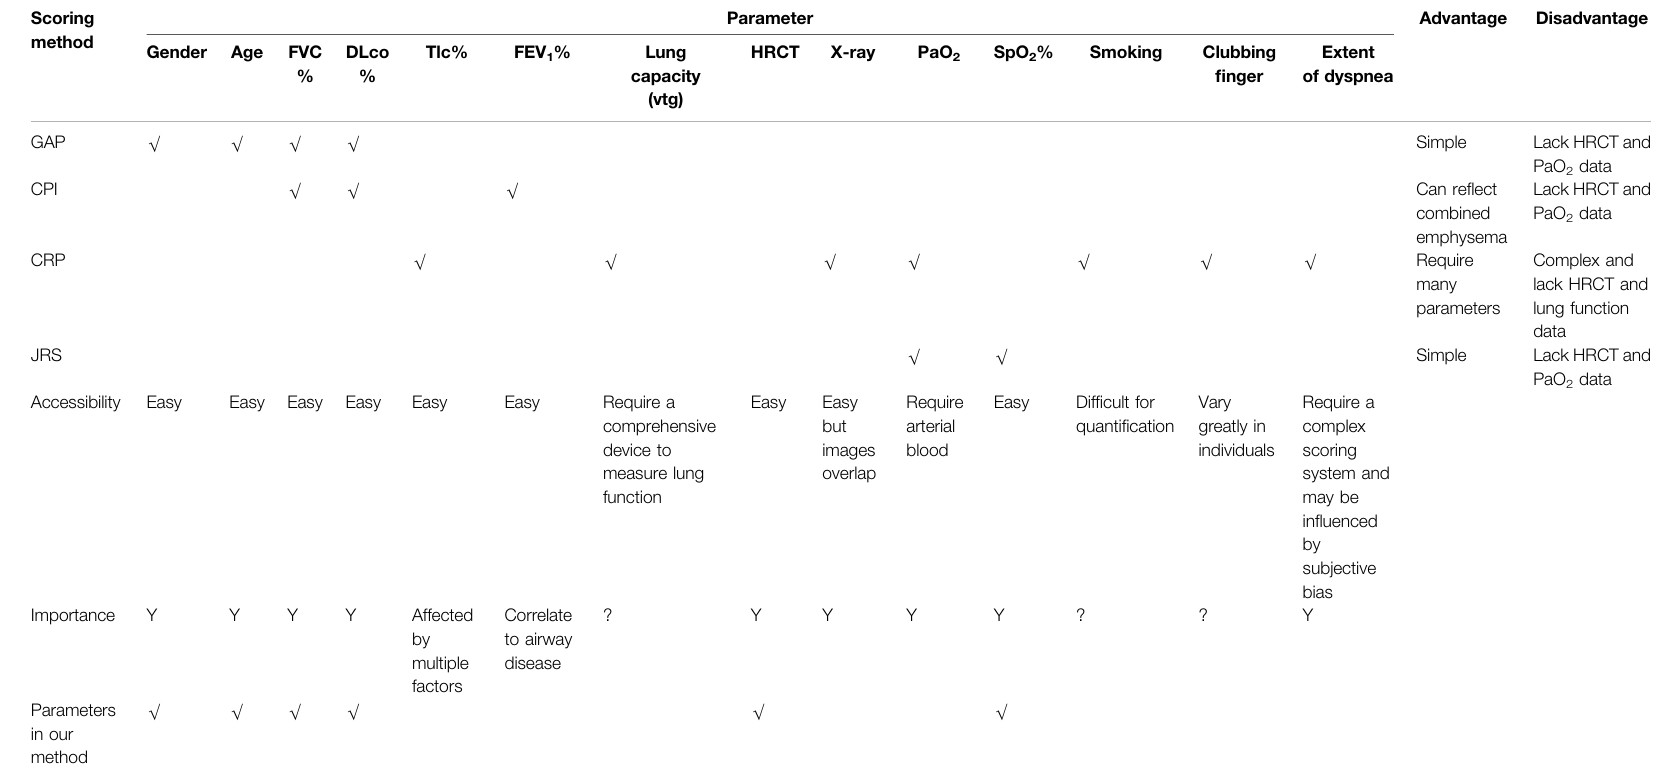
TABLE 1 | Comparison of different pulmonary staging